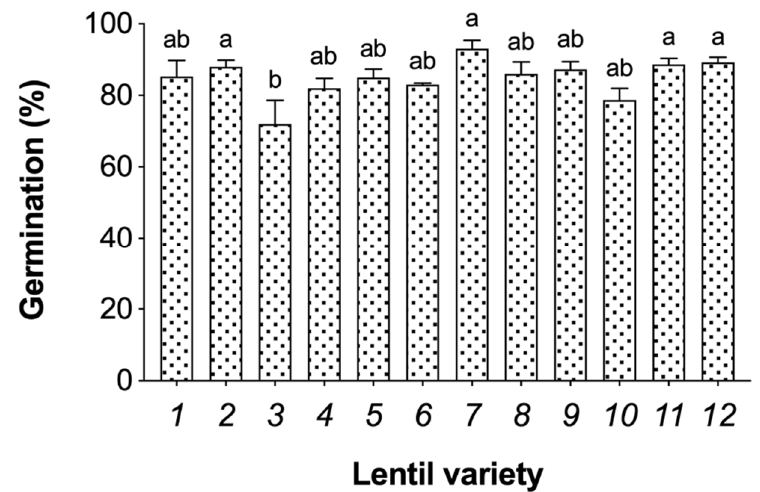
Figure 1. Germination rates of the 12 lentil varieties: 1—Dunkelgrün Marmorierte; 2—Du Puy; 3—Thessalia; 4—Dimitra; 5—Samos; 6—Kleine Schwarze; 7—Rosana; 8—Flora; 9—Santa; 10—Große Rote; 11—Kleine Rote; 12—Kleine Späths II. The bars represent means ± SE ( n = 3); different letters indicate significant differences ( p ≤ 0.05) by Tukey’s Test.